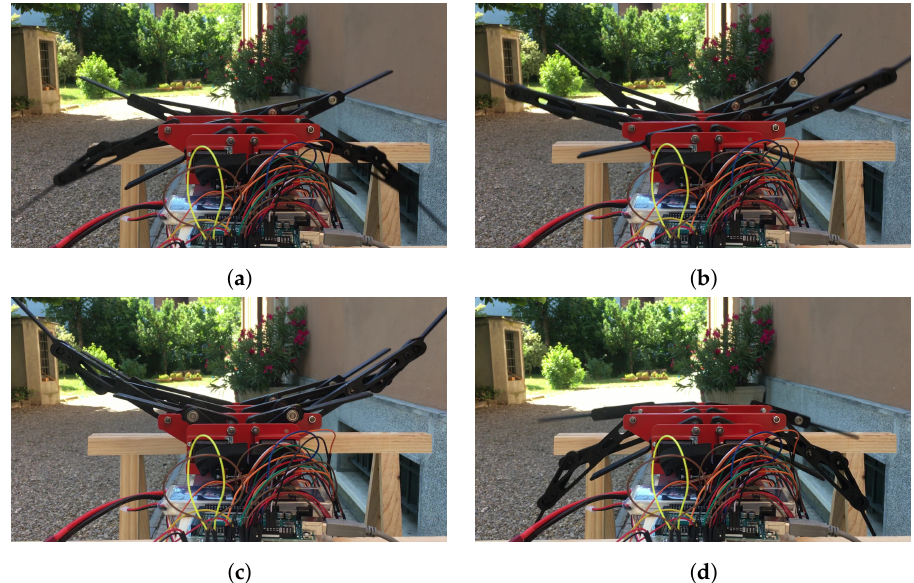
Figure 21. Instances of fin motion during forward swimming in sequence ( a – d